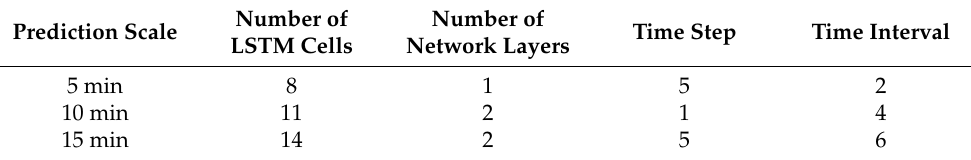
Table 1. Optimization results of the GHI prediction model parameters at different scales.